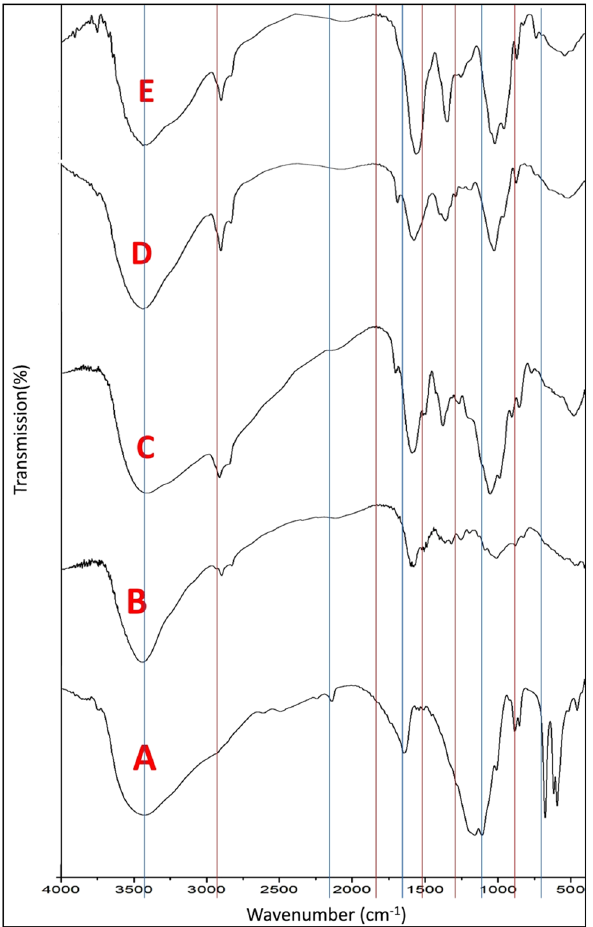
Figure 1: FTIR of ALG NPs ( A ) , CS NPs ( B ) , ALG/CS NCs ( C ) , thyme loaded - CS/ALG NCs ( D ) , and garlic loaded - CS/ALG NCs ( E )